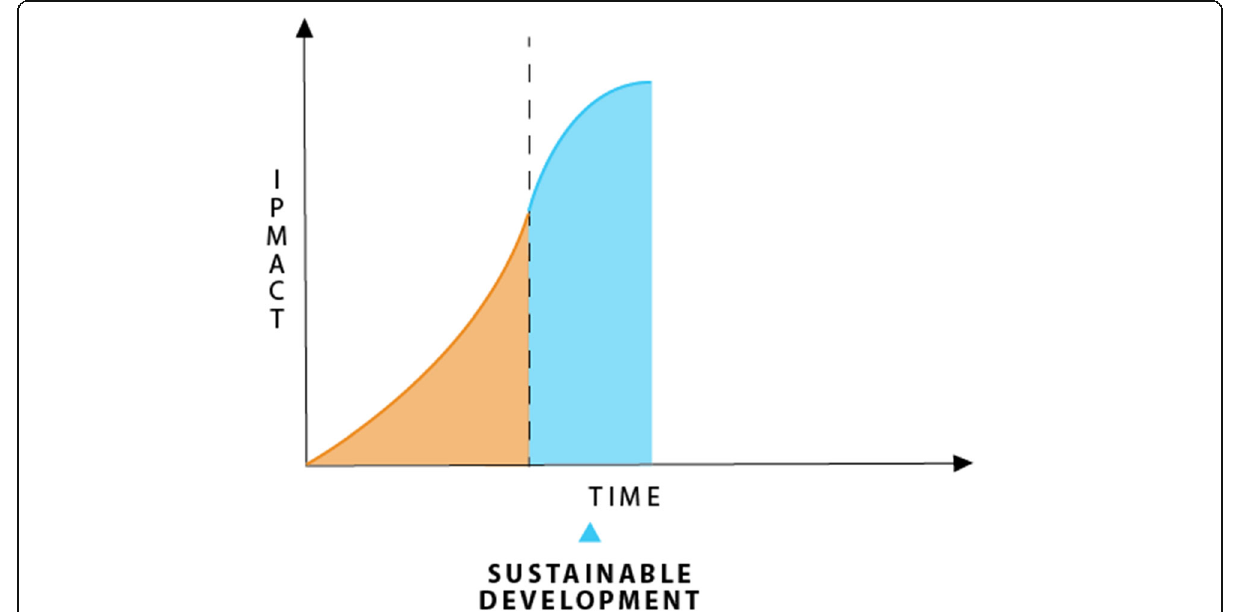
Fig. 2 Stage 2 the sustainability phase based on reducing